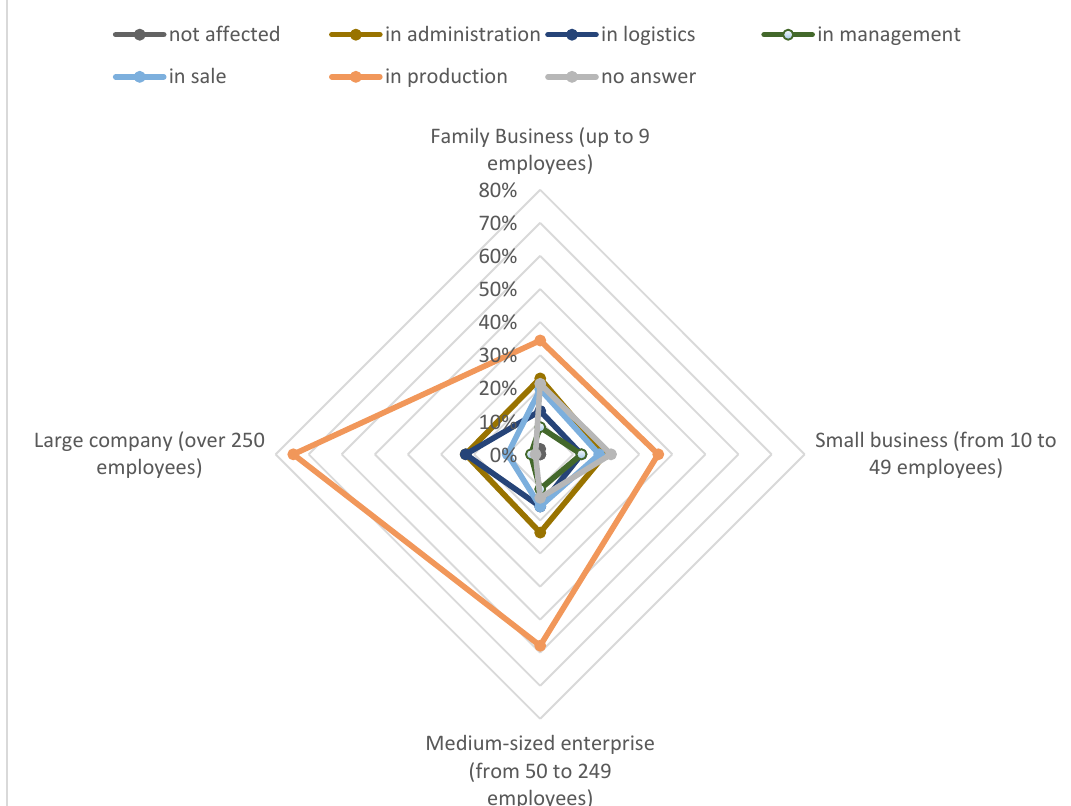
Figure 3. Departments of the company dealing with the Industry 4.0 elements implementation.